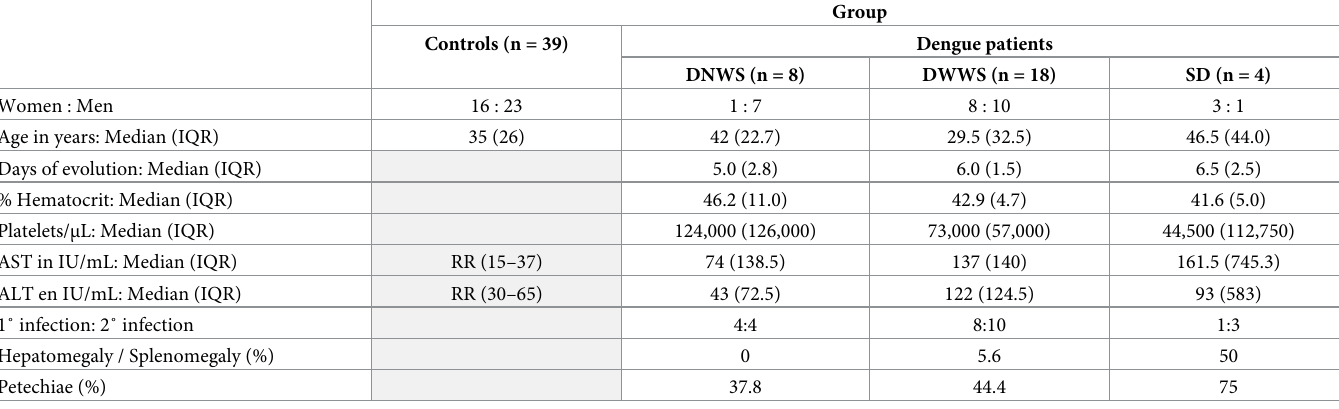
Table 1. Clinical and demographic information.